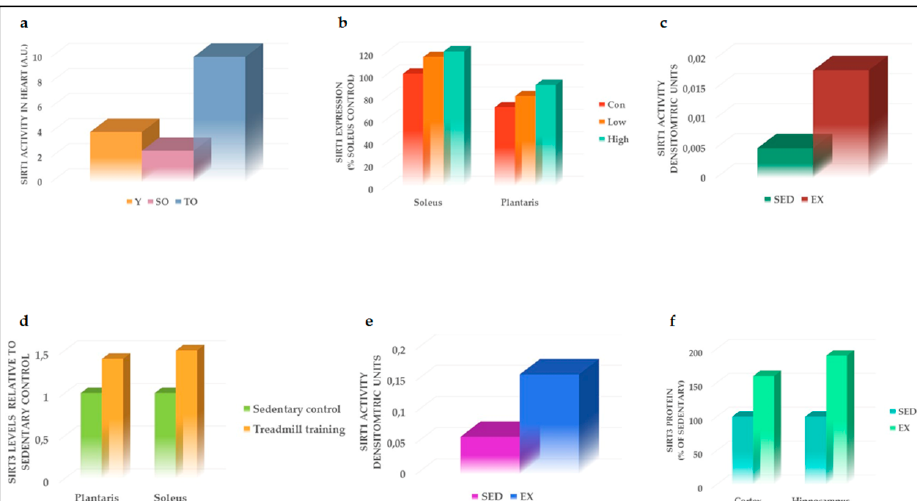
Figure 2. Effects of PA on SIRT1 and SIRT3. ( a ) PA-mediated restoration of SIRT1 activity, in the heart of old rats, modified by Ferrara et al. [32]; ( b ) SIRT1 activity improved in the soleus of rat models